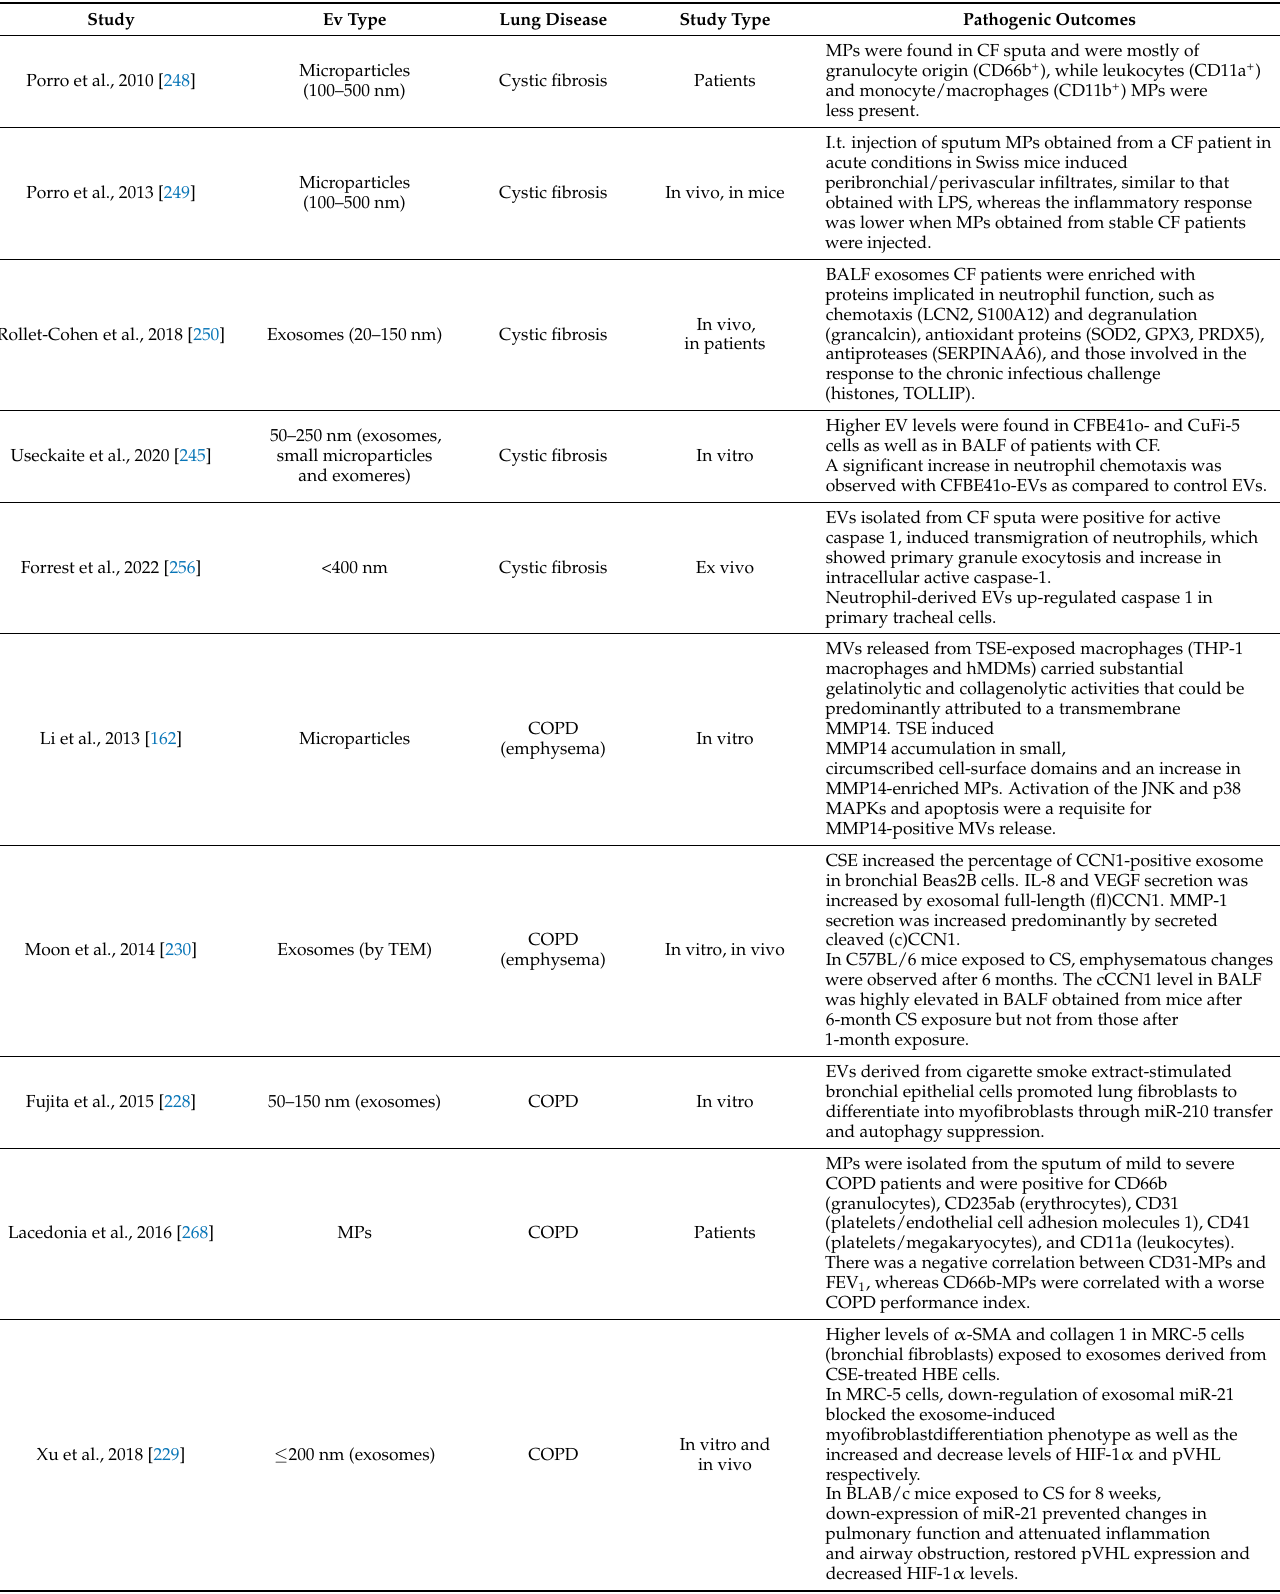
Table 1. Pathogenic roles of EVs in CF and